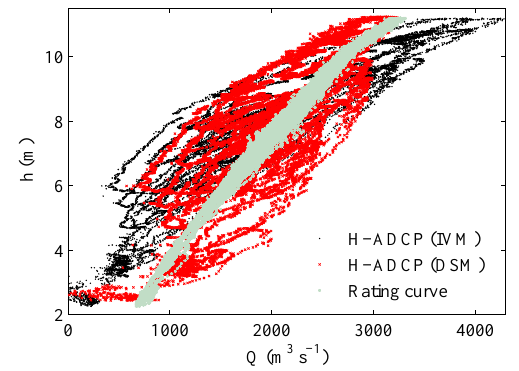
Fig. 12. Water stage versus discharge for the period between 24 May–28 June 2008. Multiple loops and discharge oscillations in- dicate variable backwater effects also occurred within the hysteresis